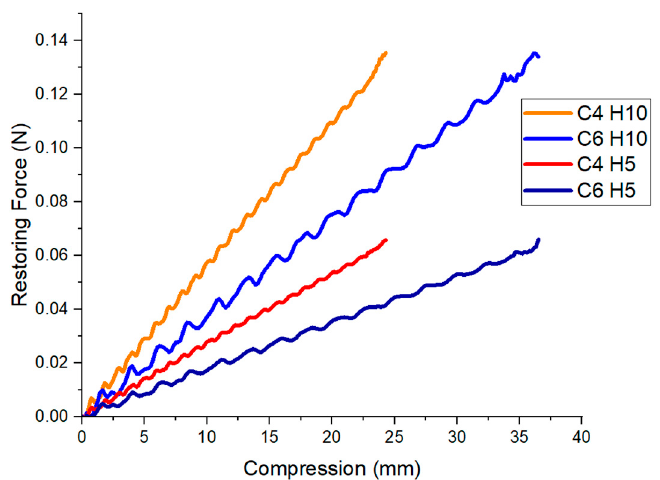
Figure 5. Force over contractile displacement extracted from the skeleton Finite Element Modelling of the four and six ‐ cell skeletons with width of 30 mm as previously described, where C stands for number of cells and H stands for skeleton height. A skeleton cell is defined as one V ‐ shaped section in the zigzag pattern of the skeleton. Skeletons were compressed to the point of self ‐ contact at the end of their compression.